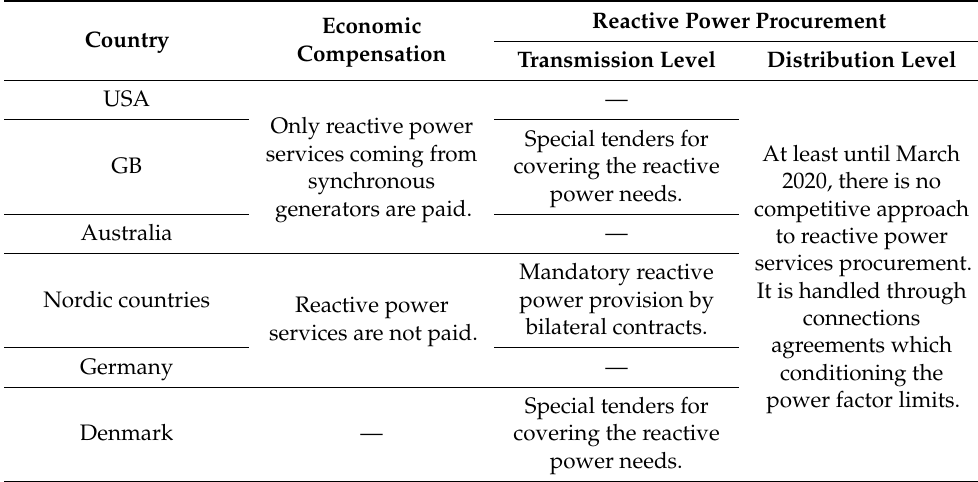
Table 1. Reactive power management policies in different countries